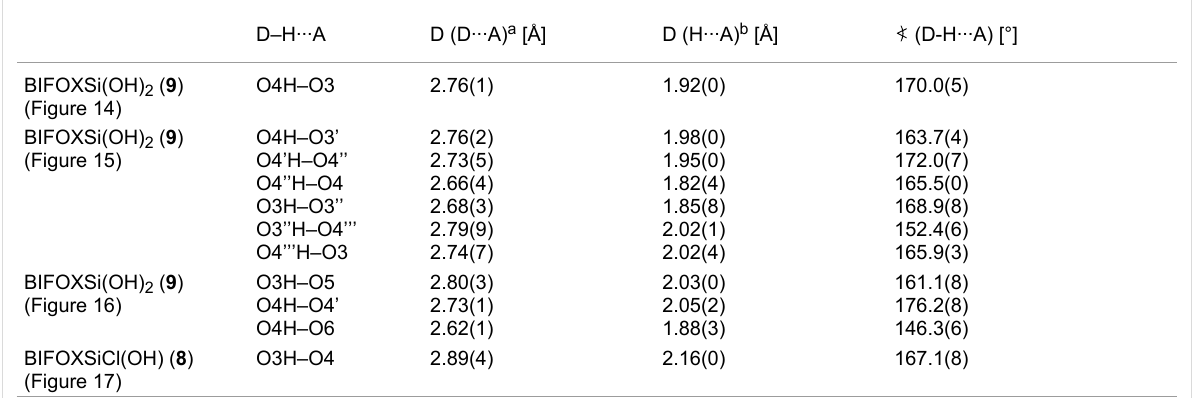
Table 5: Bond lengths and angles of hydrogen bonds in X-ray crystal structures of BIFOXSiCl(OH) ( 8 ) and BIFOXSi(OH) 2 ( 9 ).